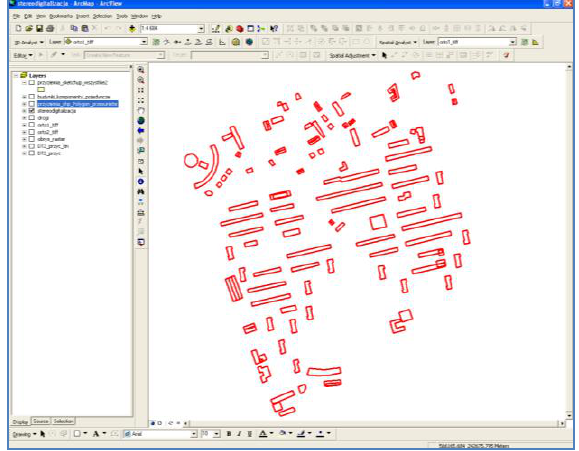
Fig. 6 Stereo digitized roofs of buildings in the shape